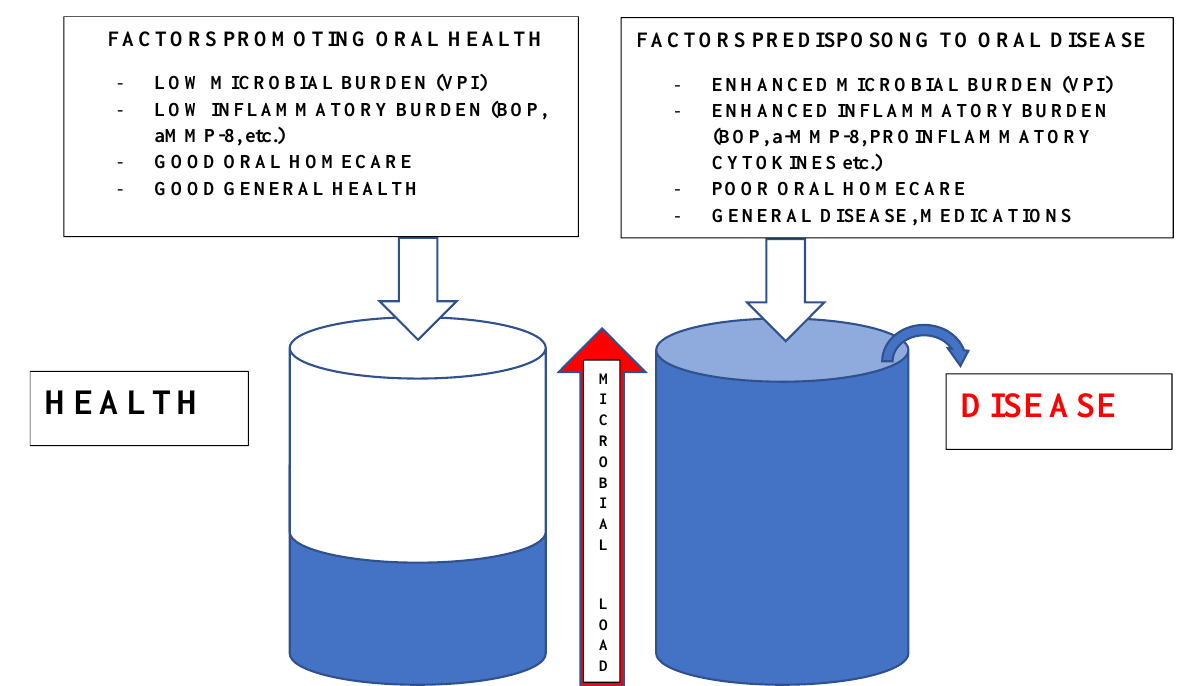
Figure 1. Illustration of some factors affecting healthy and diseased state in the oral environment. VPI (visible plaque index), BOP (bleeding on probing), aMMP-8 (active matrix metalloprotease-8).